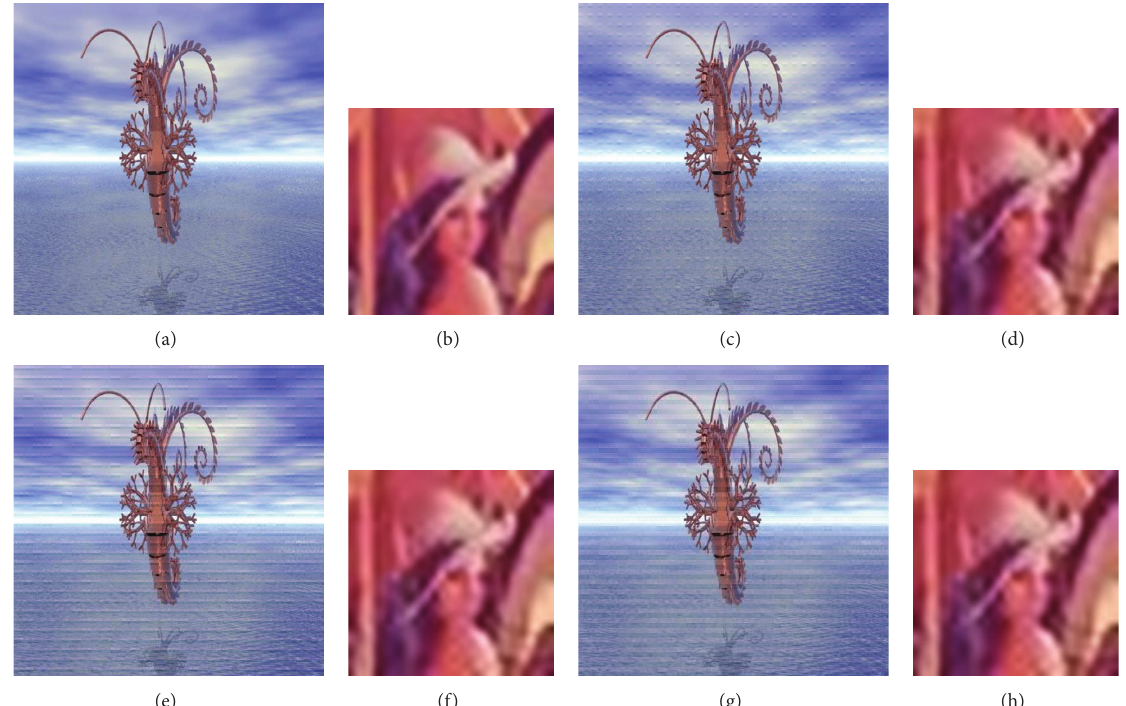
Figure 12: Comparison between the classical nonblind video multiple watermarking system (color image watermark) and the proposed method where (a) and (b) show original video frame and original watermark, (c) and (d) show watermarked video frame and recovered watermark without interlacing, (e) and (f) show watermarked video frame and recovered watermark with one-level interlacing, and (g) and (h) show watermarked video frame and recovered watermark with two-Level interlacing.